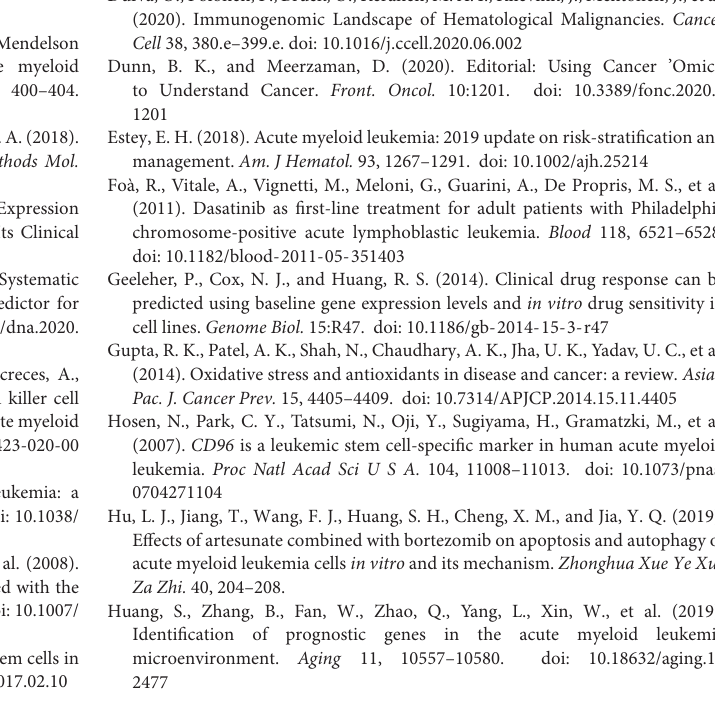
Metformin, and Paclitaxel. (C) Analysis of gene mutation frequency in the high-risk and low-risk groups. At the bottom of the image, the yellow fragment corresponds to the high-risk group, the blue bars represent the low-risk group, and the colored bars represent the different types of mutations. Supplementary Figure 4 | GSEA enrichment analysis. (A) Showed the significant enrichment of some pathways in GO enrichment analysis. GO results showed that patients in the high-risk group mainly enriched TUMOR NECROSIS FACTOR MEDIATED SIGNALING PATHWAY, INTERFERON GAMMA PRODUCTION, and other SIGNALING pathways. (B) Showed the significant enrichment of some pathways in KEGG enrichment analysis. Patients in the high-risk group were mainly enriched in the MEDIATED CYTOTOXICITY of NATURAL KILLER CELL, Chemokine SIGNALING PATHWAY, and other SIGNALING pathways. These results suggested that the disturbance of these signaling pathways in patients (high-risk and low-risk) may affect the prognosis of AML patients. Supplementary Figure 5 | TISIDB analysis. (A) The expression profile of cell receptor-related genes in the high-risk and low-risk groups. The results showed that the expression profile of cell receptor-related genes in the high-risk group was slightly higher than that in the low-risk group. (B) Expression profiles of immuno-regulatory and chemokine-related genes in the high-risk and low-risk groups. In addition to differences in MHC , Immuno-inhibitor , Immuno-stimulator , and Immuno-stimulator gene in the high-risk group (the expression was generally higher in the high-risk group), no significant difference was found in other genes in the high-risk group. (C) Correlation analysis of the expression of immuno-regulatory sub-genes and risk scores. The results showed that CD96 , TGF β 1 , CD160 , IL10 , and other genes were highly correlated with the immune score. Supplementary Figure 6 | Construction of immune gene WGCNA co-expression network. (A) Sample clustering (excluding some abnormal samples). (B) Select the best soft thresholding power. (C) Construct the co-expression matrix (module recognition). (D) Similar module clustering. (E) Module visualization. (F) The correlation between module and subtype. (G) Correlation analysis of module gene and subtype. (H) Functional analysis of modular